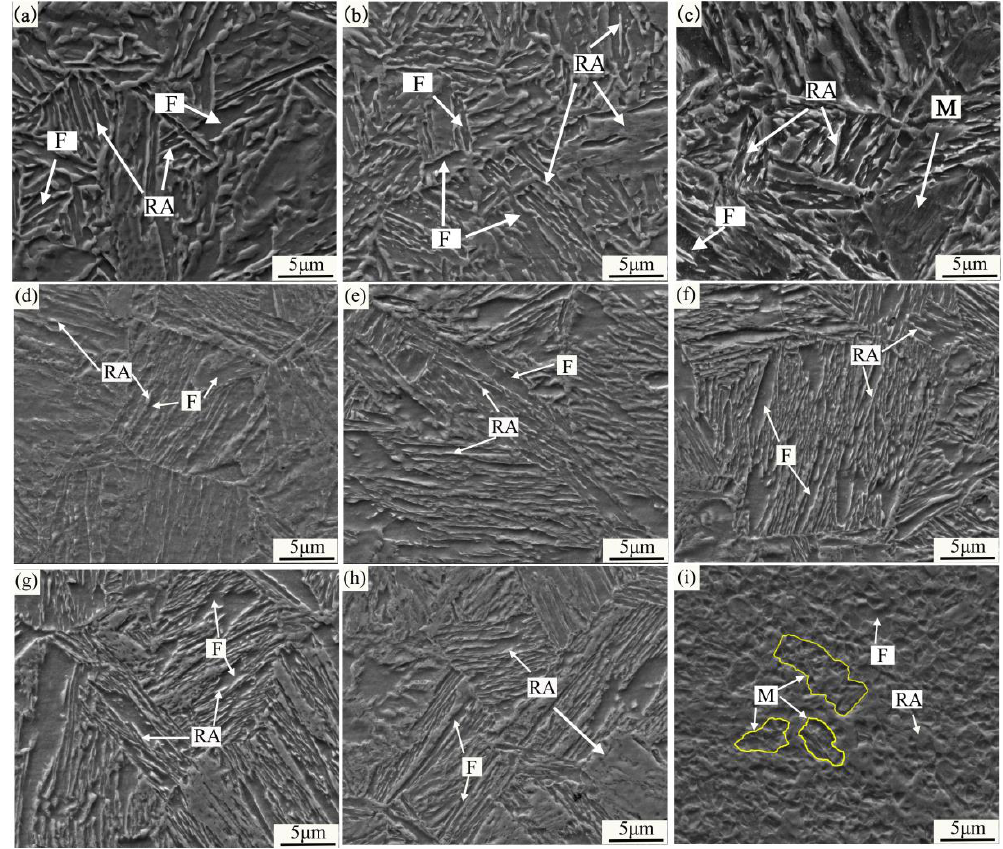
Figure 3. Scanning electron microscope (SEM) micrographs of experimental steel: ( a ) hot-rolled (HR) 625 °C, ( b ) HR 650 °C, ( c ) HR 690 °C, ( d ) cold-rolled (CR) 600 °C, ( e ) CR 625 °C, ( f ) CR 650 °C, ( g ) CR 675 °C, ( h ) CR 700 °C, and ( i ) CR750 °C (RA, retained austenite; F, ferrite; M, martensite).